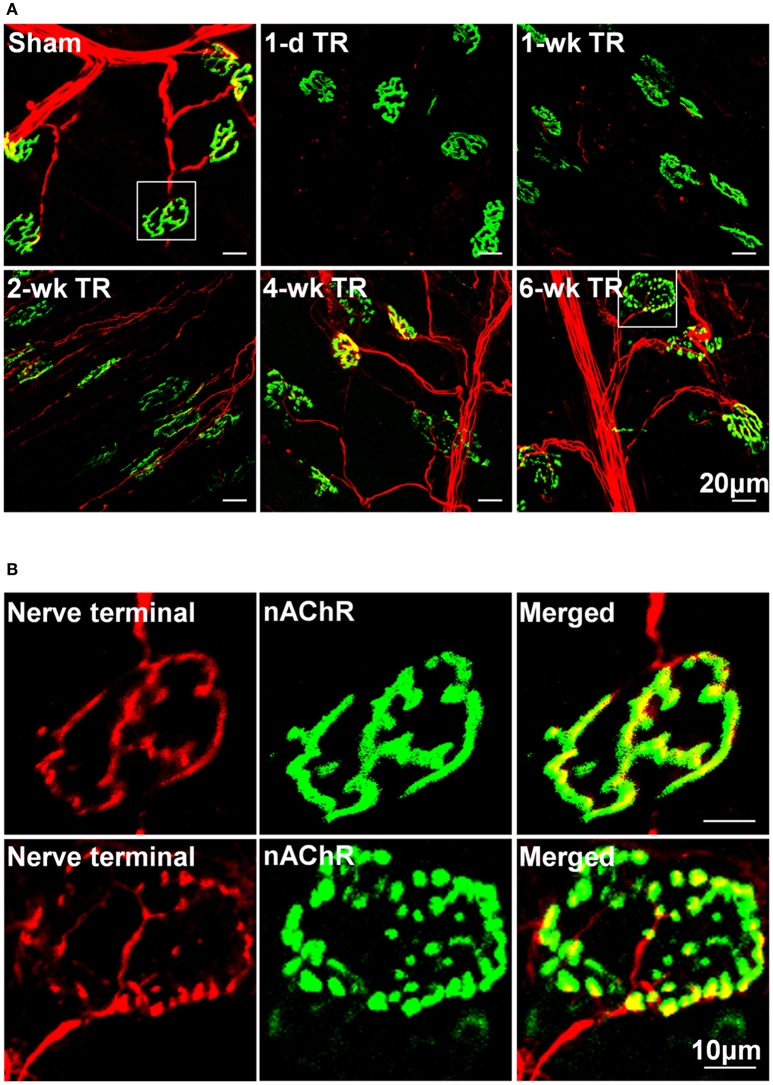
(A) Morphological changes in NMJs located on gastrocnemius muscles from sham mice and mice with different periods of tourniquet release after 3 h of tourniquet (1-d TR, 1-wk TR, 2-wk TR, 4-wk TR, and 6-wk TR). (B) Amplified photomicrographs for one NMJ in sham and 6-wk TR mice. Synaptophysin and neurofilament 200 (red color) and α-bungarotoxin (BTX; green color) were used to label presynaptic nerve terminals and post-synaptic nAChR clusters in NMJs.